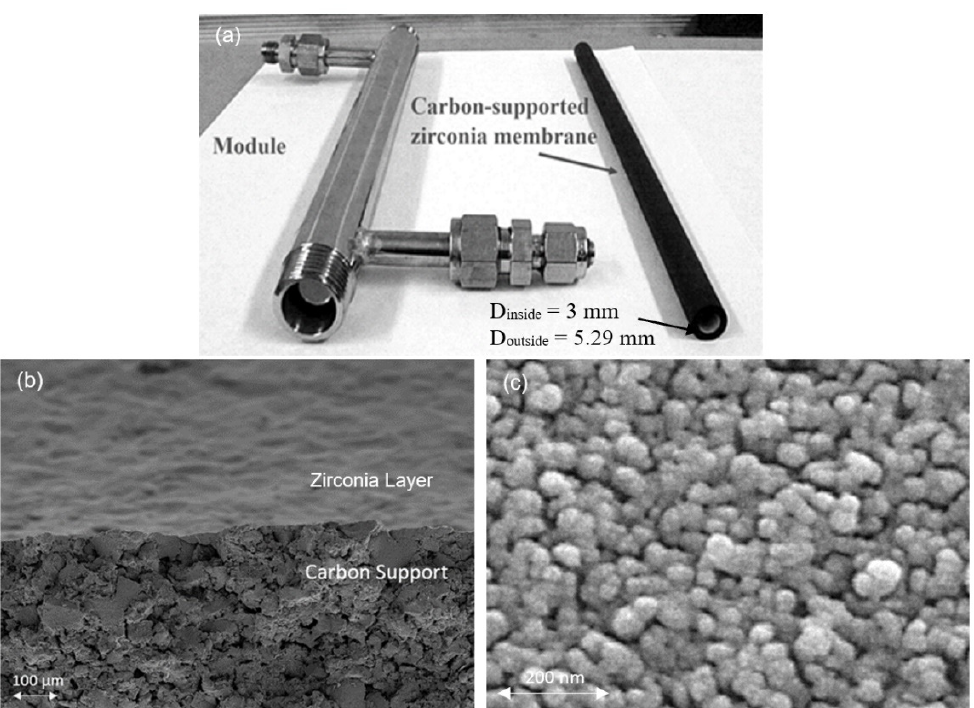
Figure 1. ( a ) Carbon-supported zirconia membrane and membrane module and Scanning Electron Microscope (SEM) image of the tubular carbon-supported ZrO 2 Carbosep M1 membrane showing ( b ) cross-sectional and top view of the zirconia layer and underlying porous carbon support, and ( c ) top view of the zirconia layer at high magnification. (The SEM images were obtained using Zeiss Supra VP40 SEM (Carl Zeiss AG, Oberkochen, Germany) with an accelerating voltage of 10 keV and a spot size of 100–10,000 nm. Prior to SEM characterization, the membrane sample was sputter-coated (Hummer ® 6.6 Sputter Coater, Anatech USA, Sparks, NV, USA) for 3 min with a thin film of gold (Au) to prevent charging during SEM imaging).